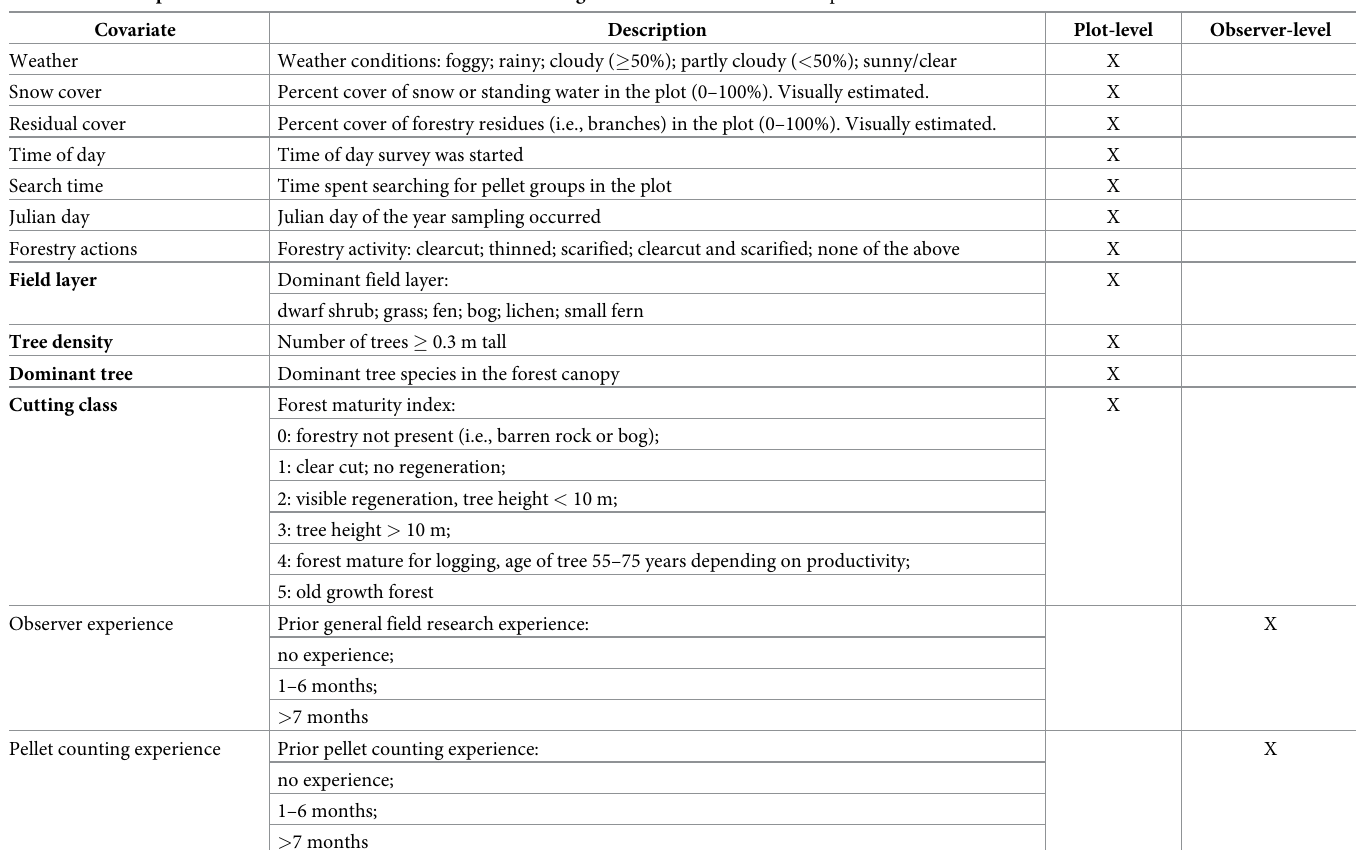
Table 1. Table of plot- and observer-level covariates used in modeling. Covariates in bold were extrapolated from the 2018 dataset. Covariate Description Plot-level Weather Snow cover Percent cover of snow or standing water in the plot (0–100%). Visually